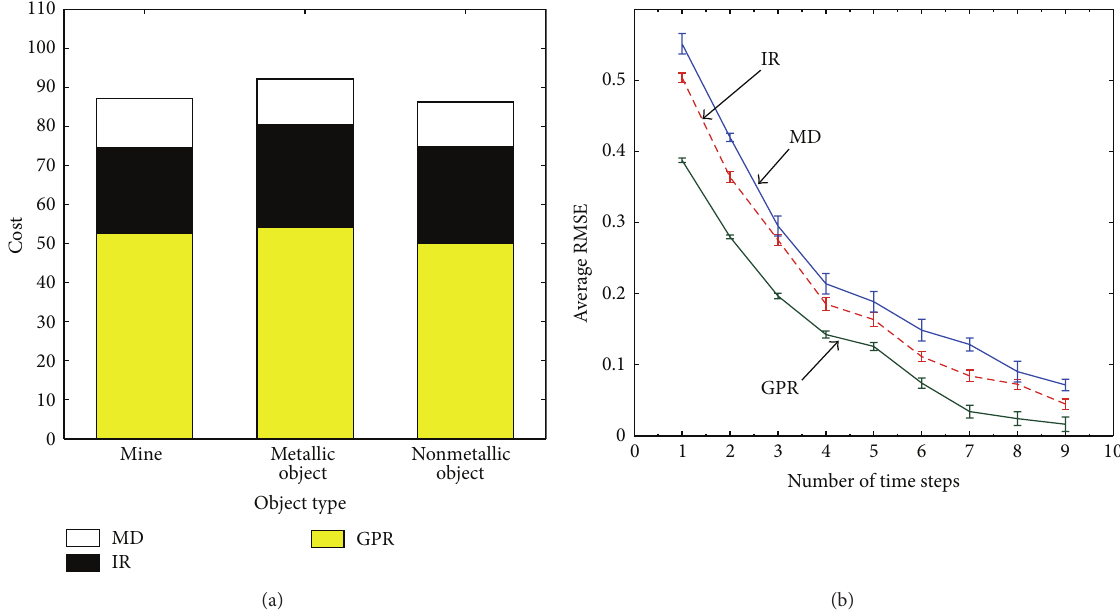
Figure 12: (a) Cost to classify different types of objects, mines and metal but not mine and nonmetal, using different types of sensors. Relative costs of sensing using MD, IR, and GPR were assumed to be in the ratio of 1:2 : 4. (b) Root mean square error from different types of sensors when used individually over time at the same object of interest. Note that although using MDs along has a low cost, their RMSE is higher (accuracy is